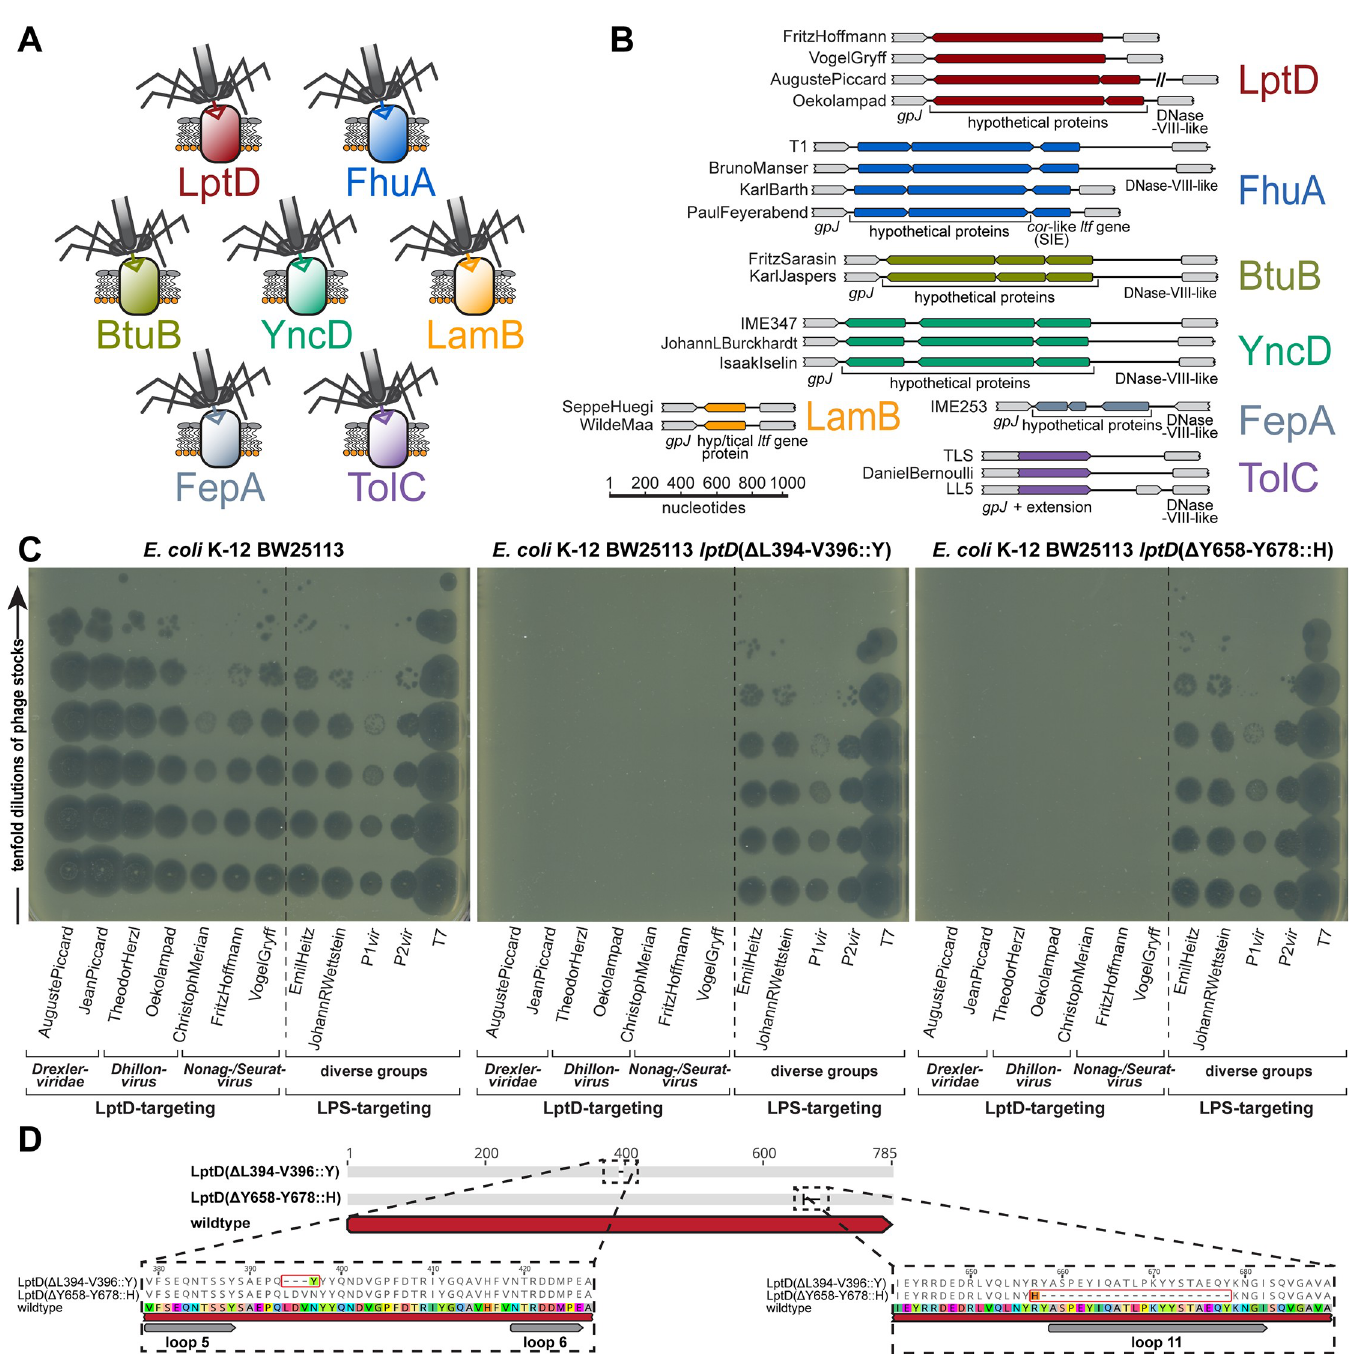
Fig 4. Shared bona fide RBP loci of small siphoviruses mediate specificity to terminal receptors including LptD. (A) The 7 identified receptors of small siphoviruses are shown with a color code that is also used to annotate demonstrated or predicted receptor specificity in the phylogenies of Figs 3D, 5D, and 5E. (B) We show representative bona fide RBP loci that seem to encode the receptor specificity of the small siphoviruses studied in this work (same color code as in (A)). Note that the loci linked to each receptor are very similar while the genetic arrangement differs considerably between loci linked to different terminal host receptors (see also S1B Fig). (C) Whole-genome sequencing of bacterial mutants exhibiting spontaneous resistance to 7 small siphoviruses with no previously known receptor revealed different mutations or small deletions in the essential gene lptD that encodes the LptD LPS export channel. Top agar assays with 2 representative mutants in comparison to the ancestral E . coli K-12 BW25113 strain were performed with serial 10-fold dilutions of 12 different phages (undiluted high-titer stocks at the bottom and increasingly diluted samples toward the top). Both mutants display complete resistance to the 7 small siphoviruses of diverse genera within Drexlerviridae and Siphoviridae families that share the same bona fide RBP module (S1B Fig) while no other phage of the BASEL collection was affected. We excluded indirect effects, e.g., via changes in the LPS composition in the lptD mutants, by confirming that 5 LPS-targeting phages of diverse families (see below) showed full infectivity on all strains. (D) The amino acid